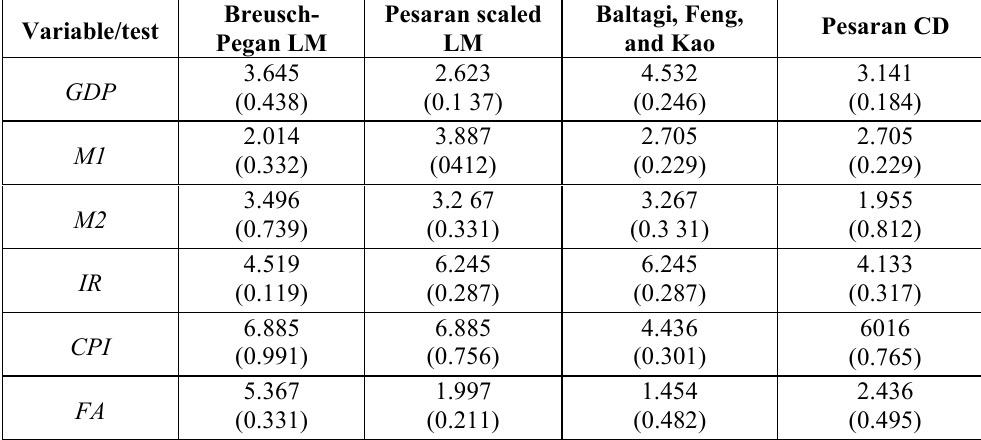
Table 1 . Cross-Sectional Independence Test Results Variable/test Pegan LM